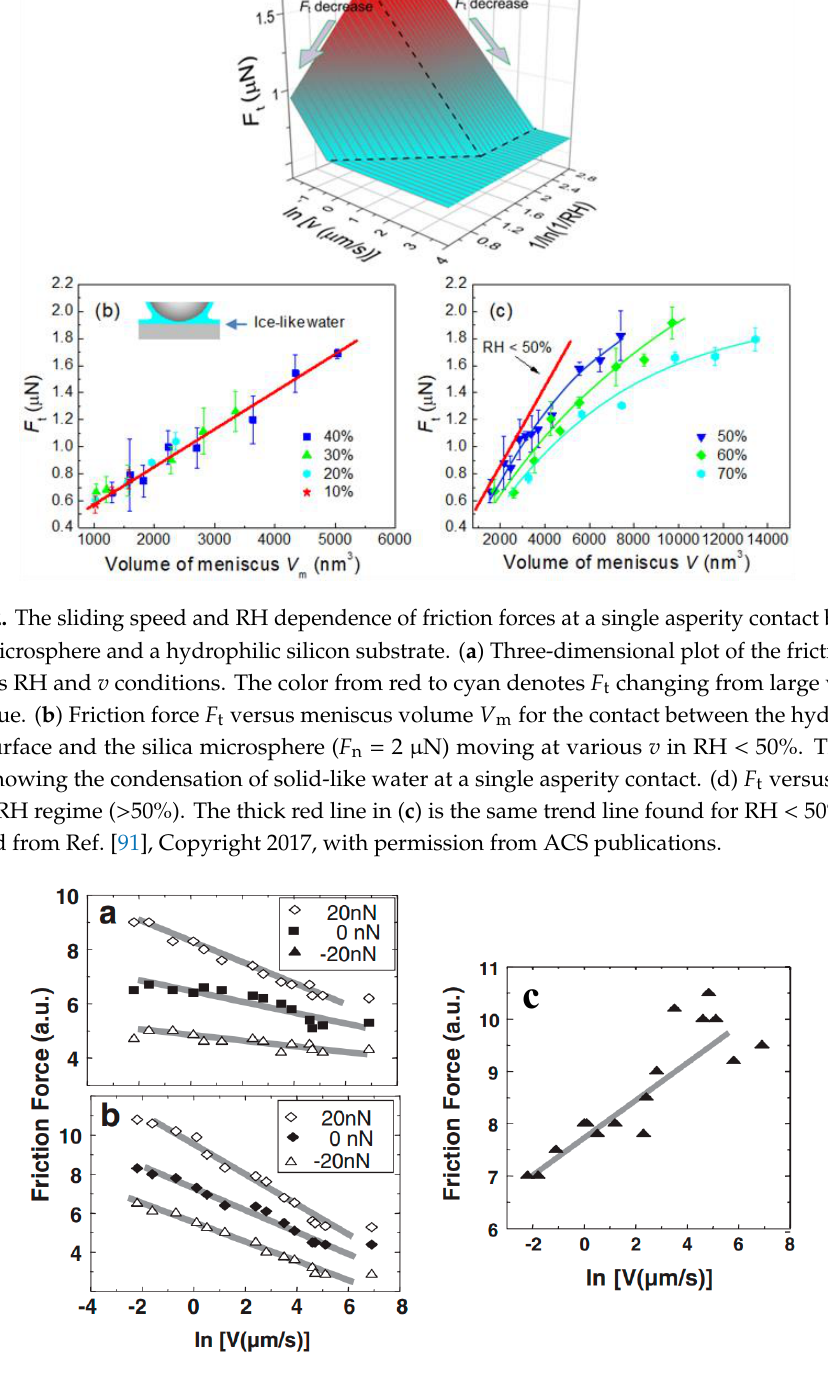
Figure 23. Semilog plot of the friction force vs. sliding velocity between a Si 3 N 4 tip and samples of: ( a ) APS monolayer on mica; ( b ) Polyethylenimine monolayer on mica to produce a saturated layer of hydroxyl groups, and ( c ) APS coated mica sample after treatment with hydrochloric acid. RH = 35%. Reprinted from Ref. [91], Copyright 2006, with permission from the APS publications.